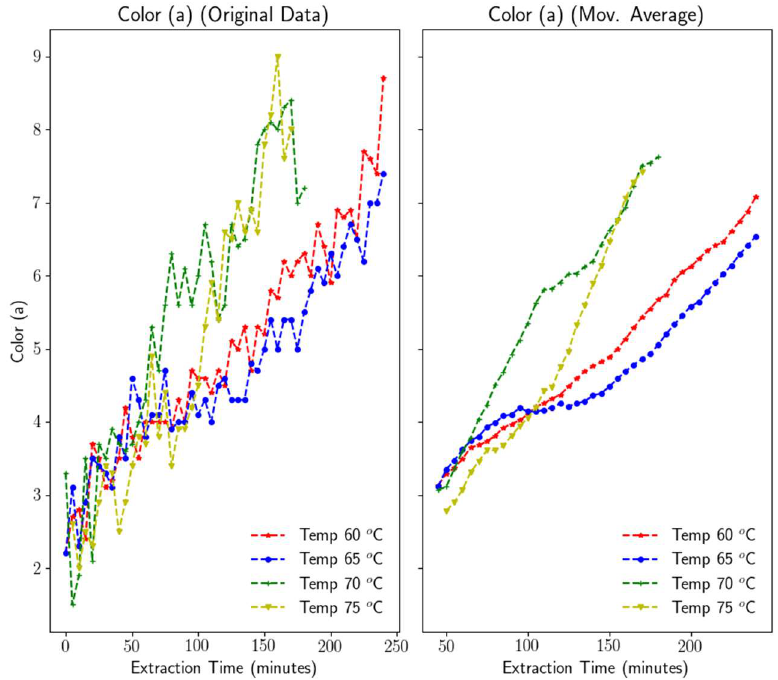
Figure 9. Color (a) with different extraction times and at different temperatures.